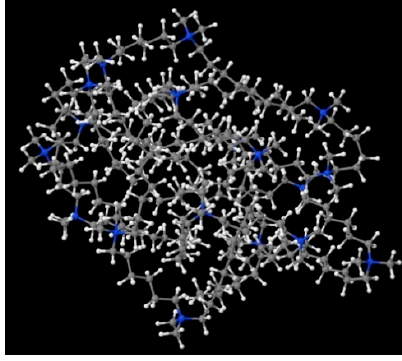
Figure 10. A possible micelle of nine 8-6-8 molecules as optimised by means of semiempirical PM7 approach, as implemented in Mopac.